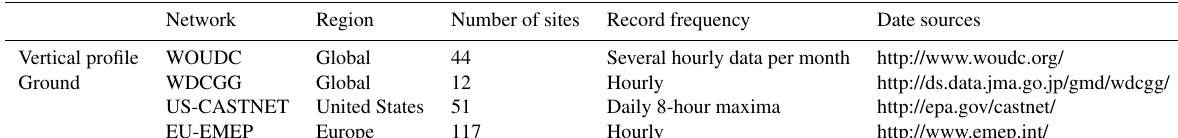
Table 2. Summary of ozone observations used for comparison with WRF-CMAQ simulations.